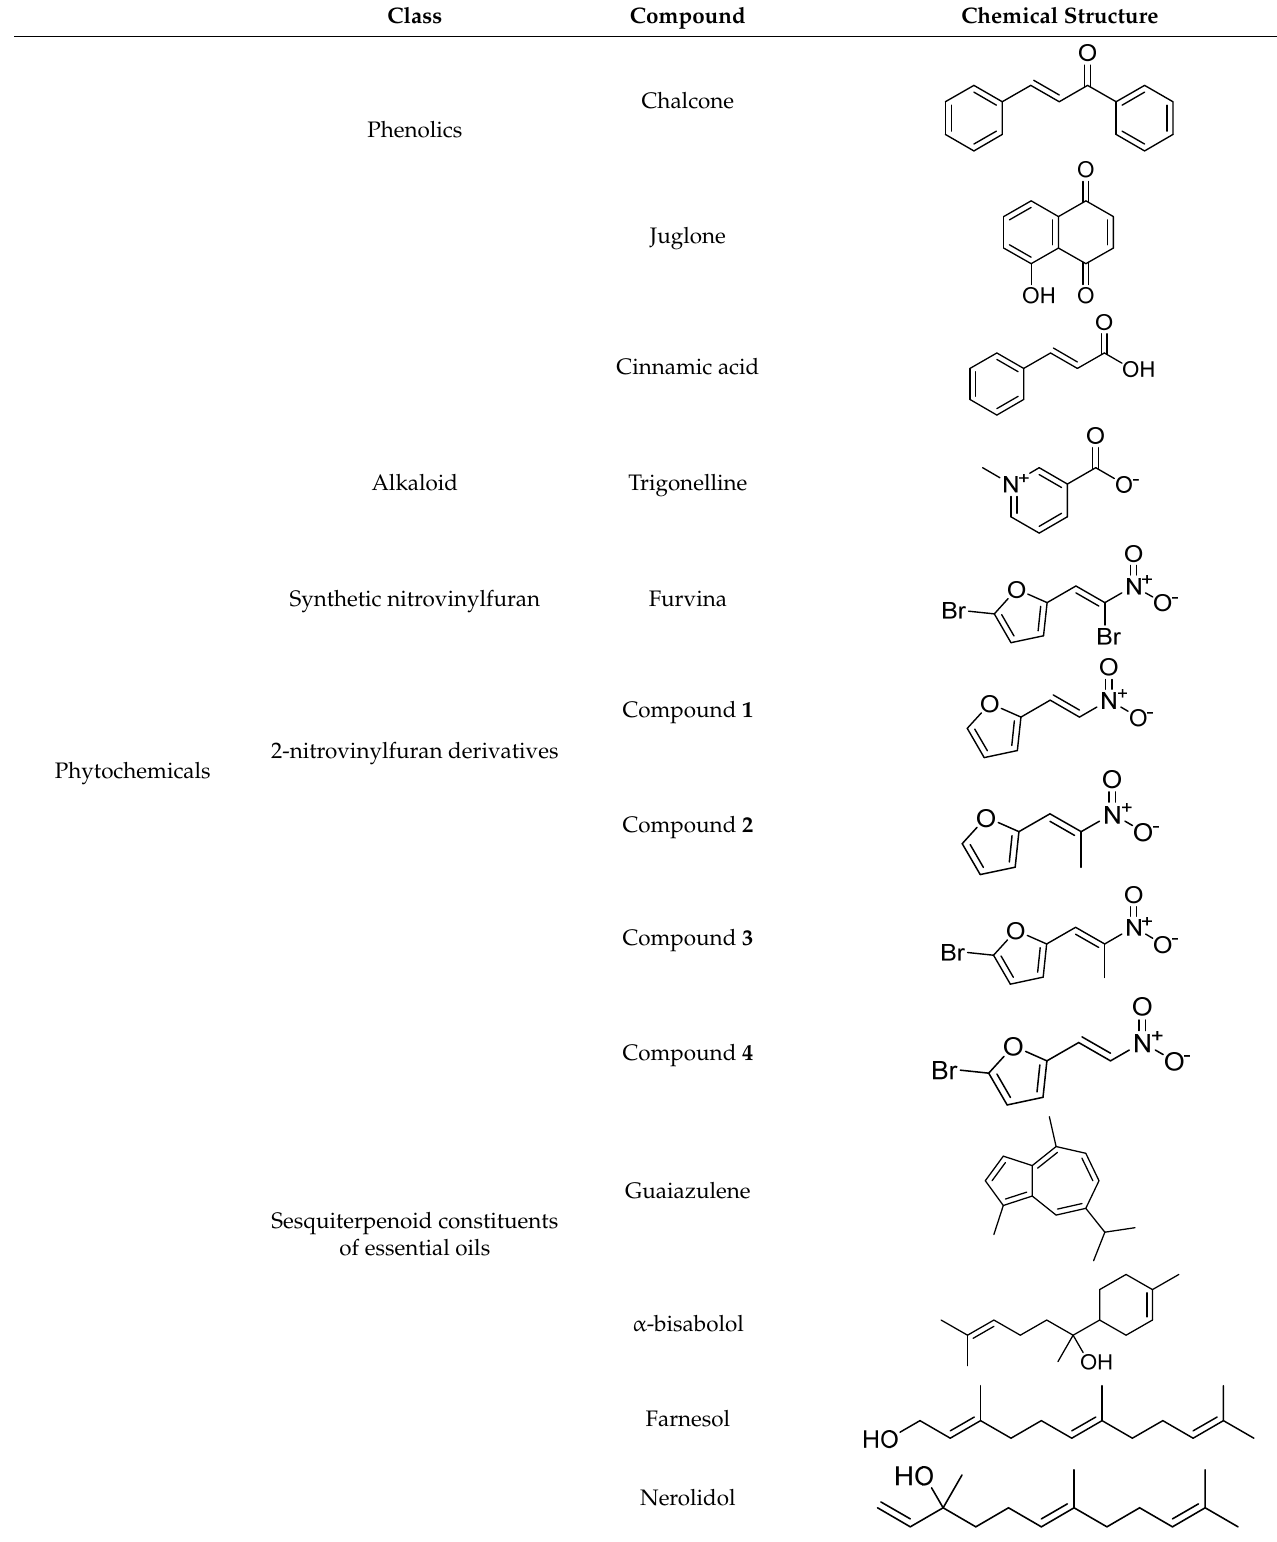
Table 1. Selected phytochemicals and derivatives, as well as antibiotics, with their respective class and chemical structure.